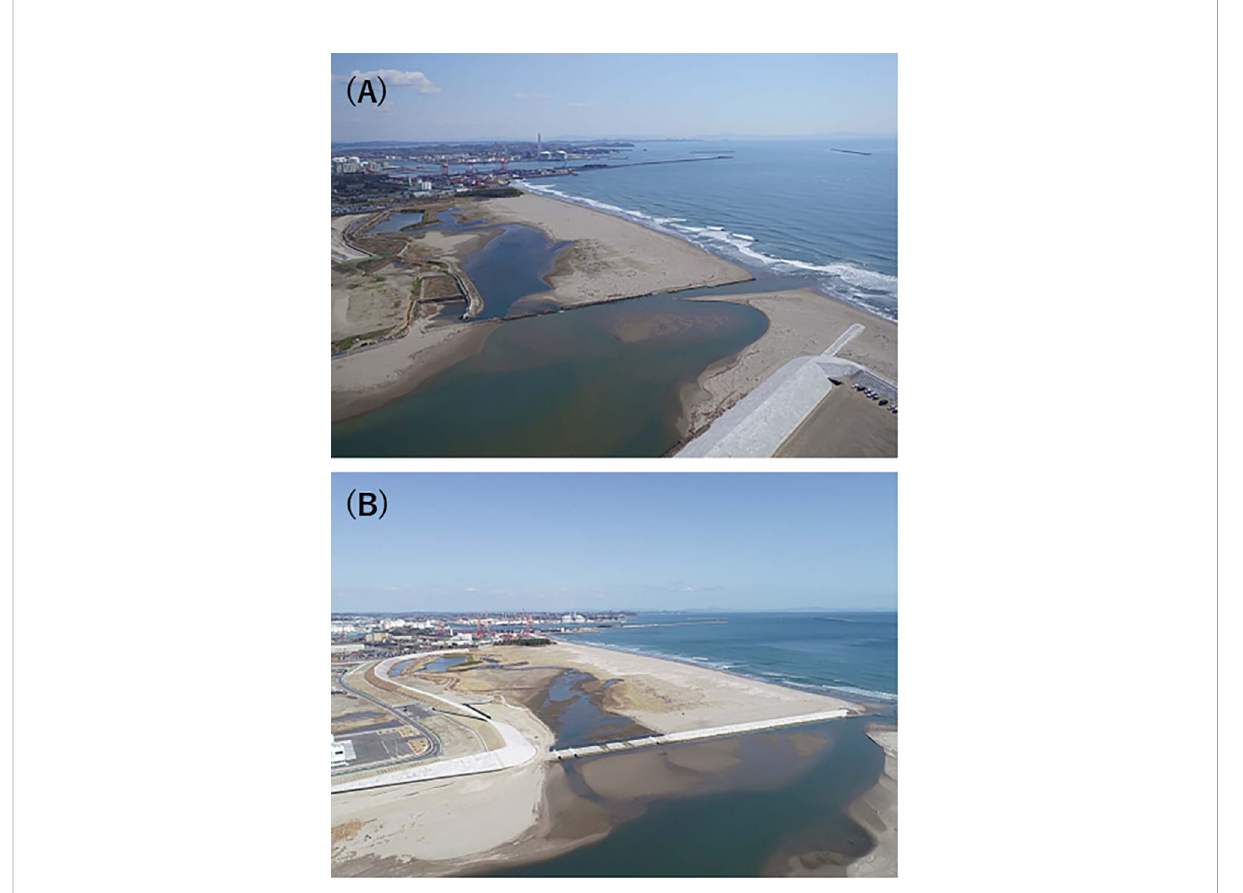
FIGURE 8 Photographs (A) before and (B) after the reconstruction of the levee in Gamo Lagoon. (A) Photographed in April 2017 and (B) March 2021 (from Public Works Department, Miyagi Prefecture, March